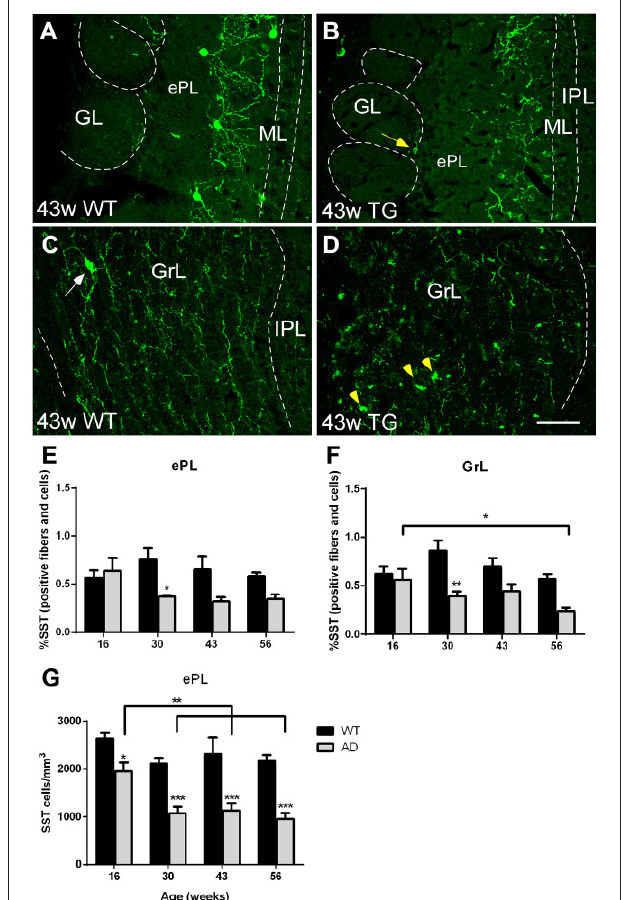
FIGURE 6 | Vulnerability analysis of somatostatin-expressing cells and fibers in the olfactory bulb. (A–D), Confocal images showing somatostatin-positive cells and fibers in the different layers of control and transgenic animals at distinct ages. (E–G) , graphics illustrating both % of area occupied by somatostatin cell bodies and fibers within ePL and GrL and the estimation of total somatostatin-positive in the ePL (cells/mm3) in control and transgenic animals. Calibration bar, 50 µ m. White arrows point to labeled cells. Yellow arrow point to labeled periglomerular cell and yellow arrowheads to